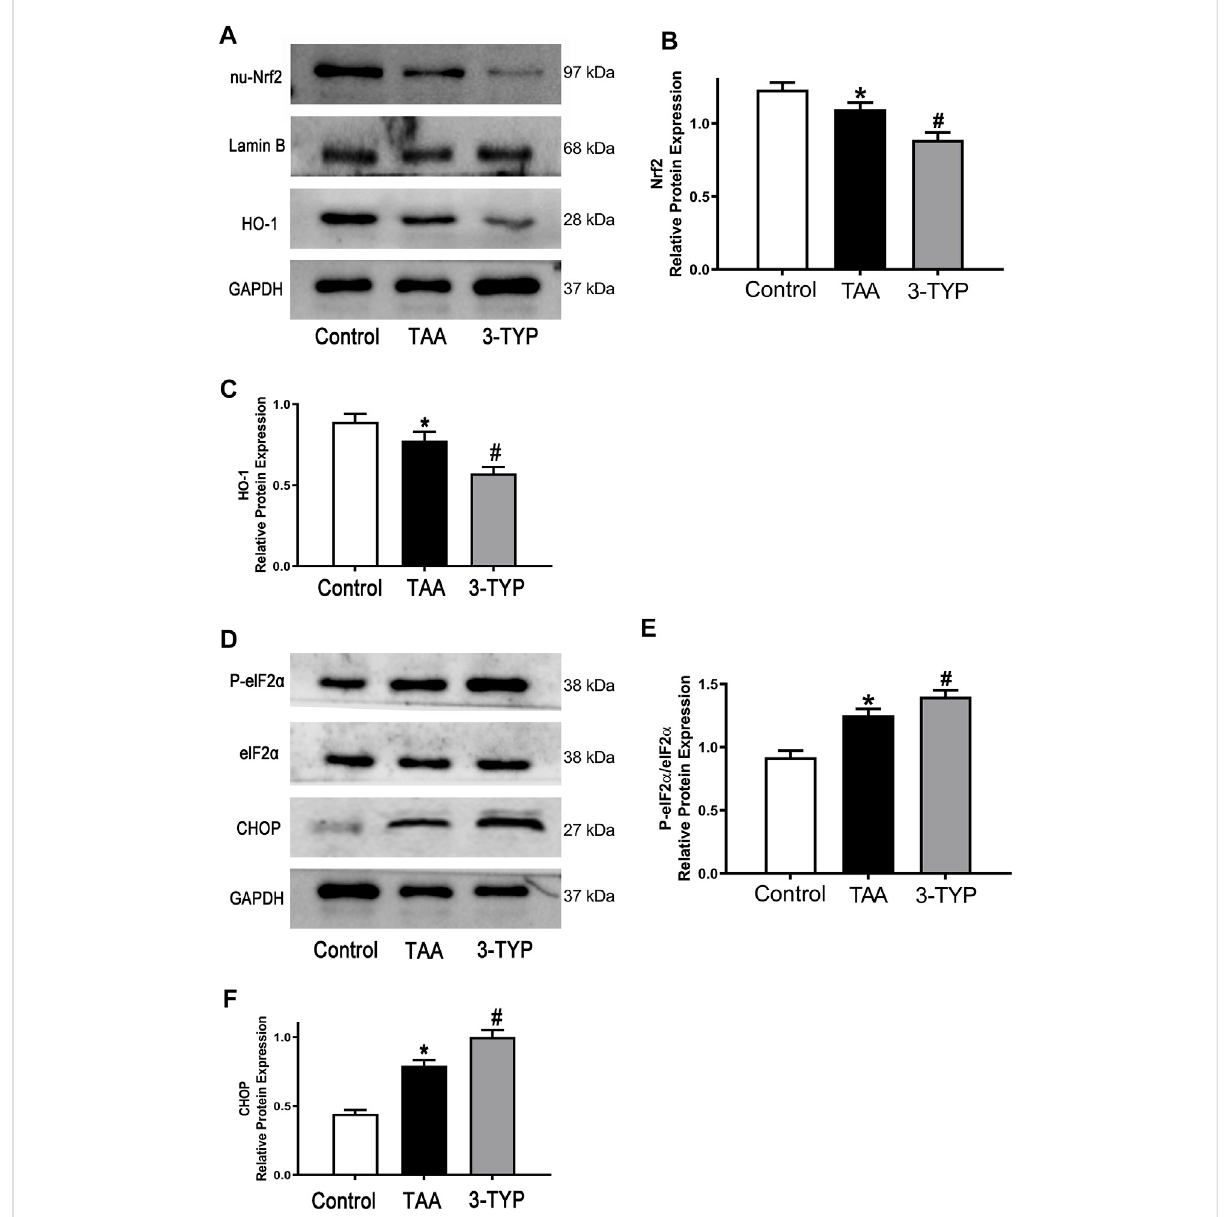
Effect of 3-TYP on activation of oxidative stress and endoplasmic reticulum stress in each group, n = 10 per group. (A) The expressions of Nrf2 and HO-1 in liver tissues were analyzed by western blotting. (B) The quantitative blots of Nrf2. (C) The quantitative blots of HO-1. (D) The expressions of p-elF2 α , elF2 α , and CHOP in liver tissues were measured by western blotting. (E) The quantitative values of p-elF2 α /elF2 α . (F) The quantitative values of CHOP. * p < 0.05, vs . the control group. # p < 0.05, vs . the TAA